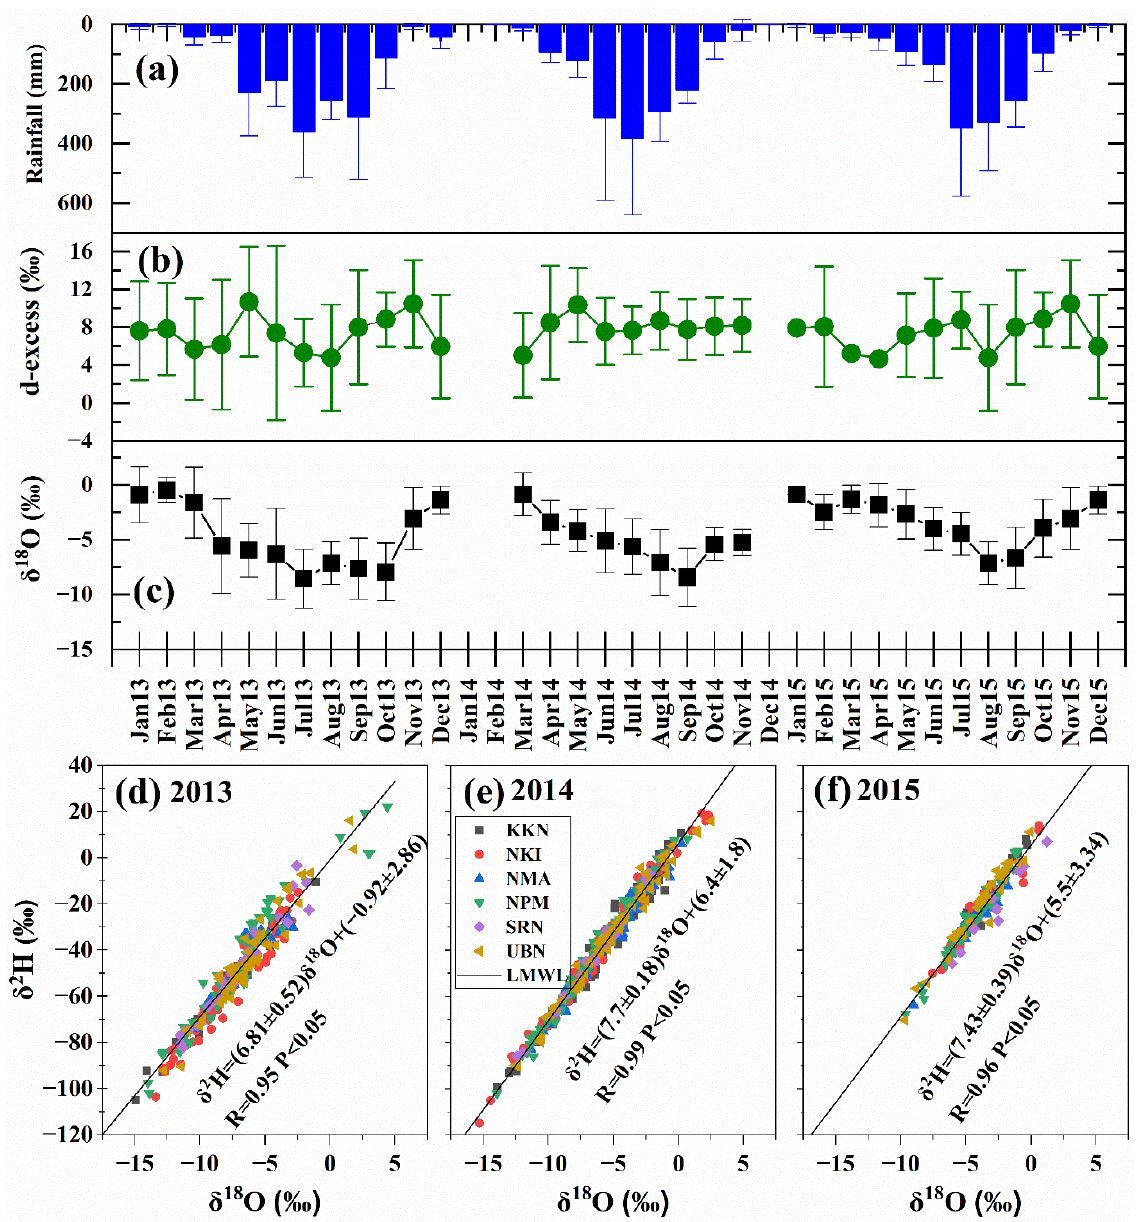
Figure 3. ( a ) Mean monthly rainfall (mm). ( b , c ) Mean monthly isotope variation. ( d – f ) LMWL.